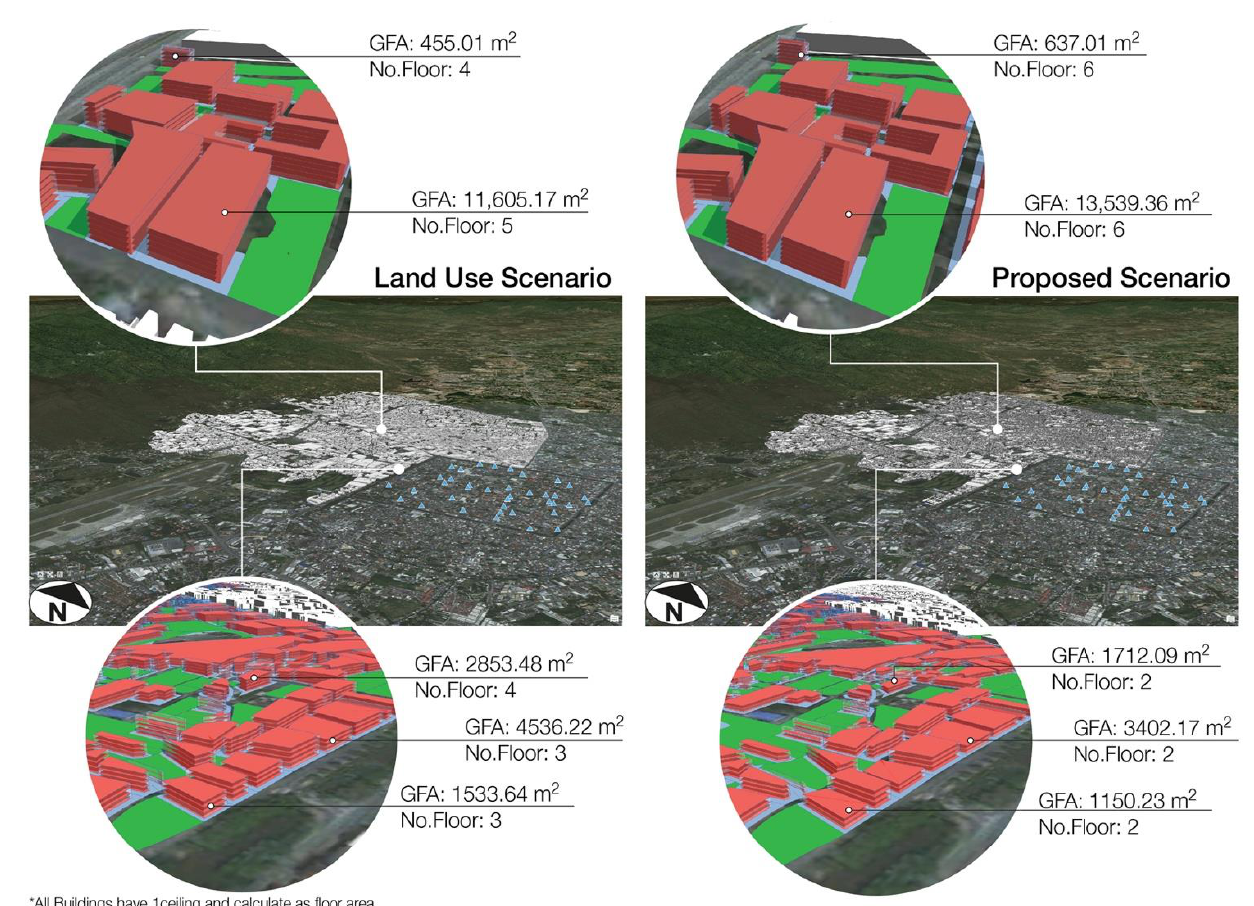
Figure 14. Comparison of development areas between LUS and PPS (Source: Authors).